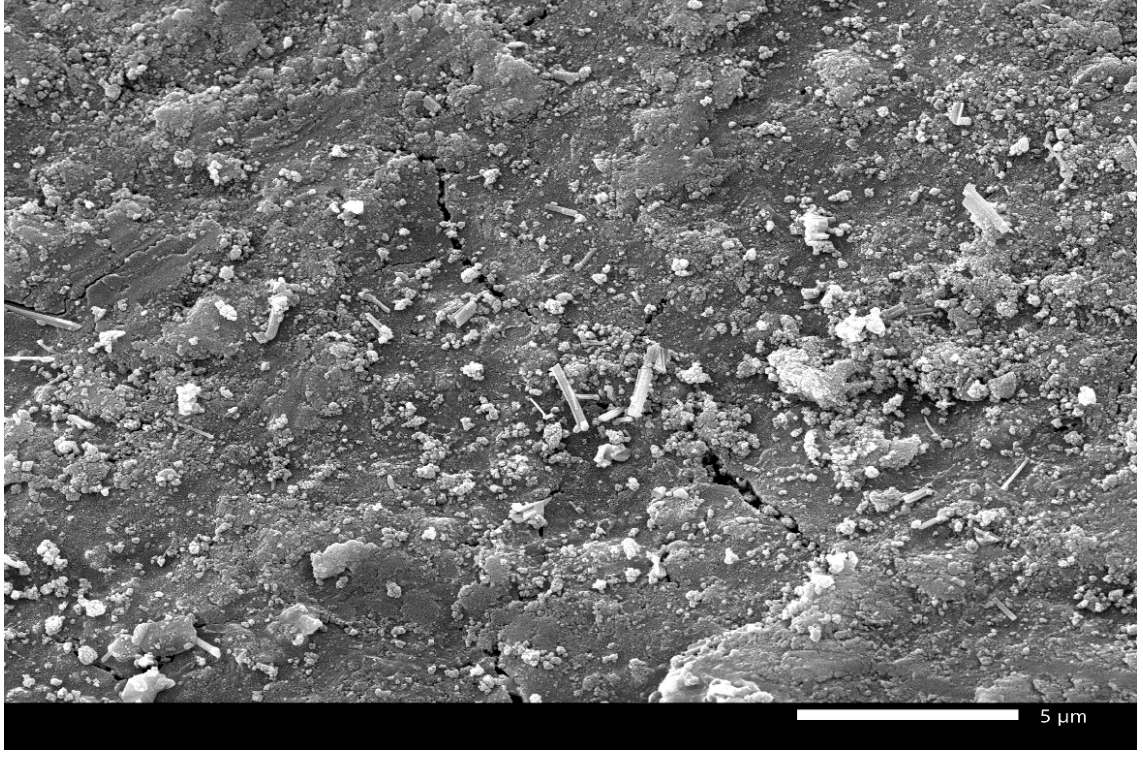
Figure 21. Photo of the spent catalyst after the blank test obtained during scanning electron microscopy